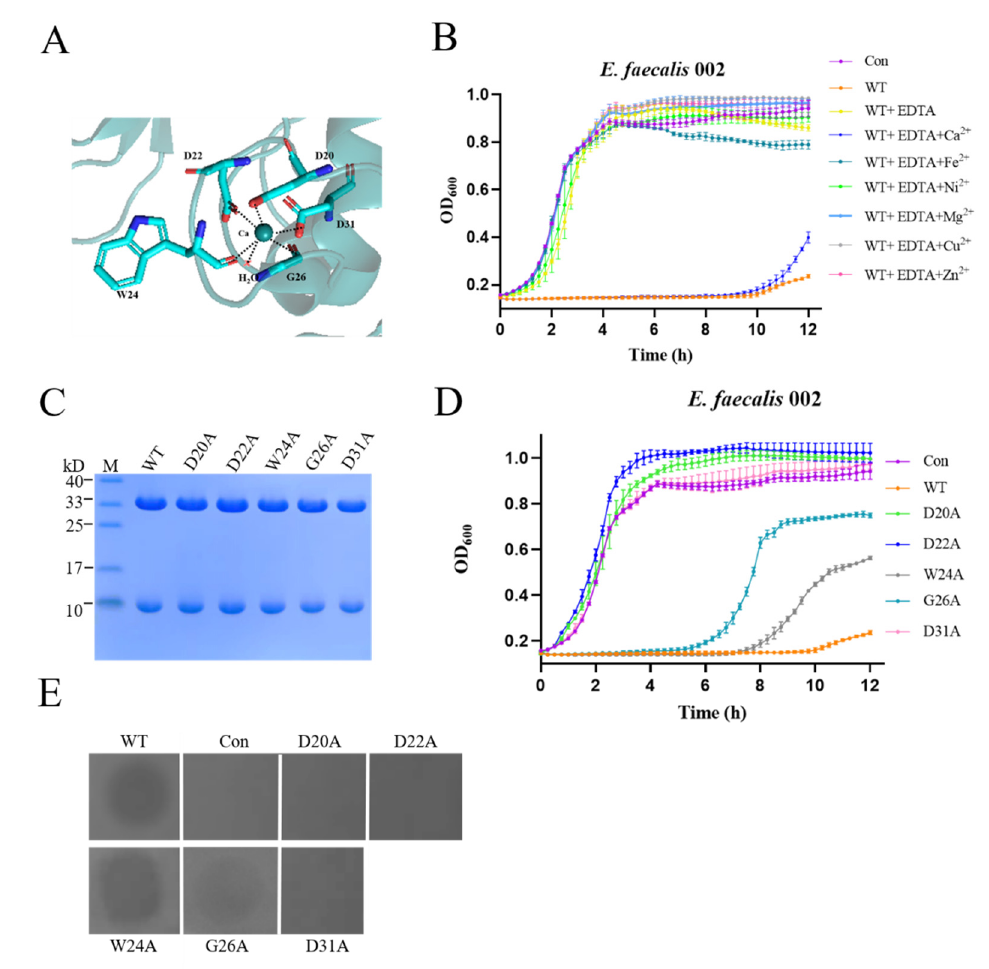
Figure 5. Effect of calcium on the lytic activity of EFm1. ( A ) Residues coordinating with calcium; ( B ) Effects of different metal ions (1 µM) on the lytic activity of EDTA-inactivated EFm1; the mean ± s.e.m is shown; ( C ) SDS-PAGE results of mutants coordinated with calcium; ( D ) Growth curves of mutants coordinated with calcium; the mean ± s.e.m is shown; ( E ) Plate lysis assay results of mutants coordinated with calcium.